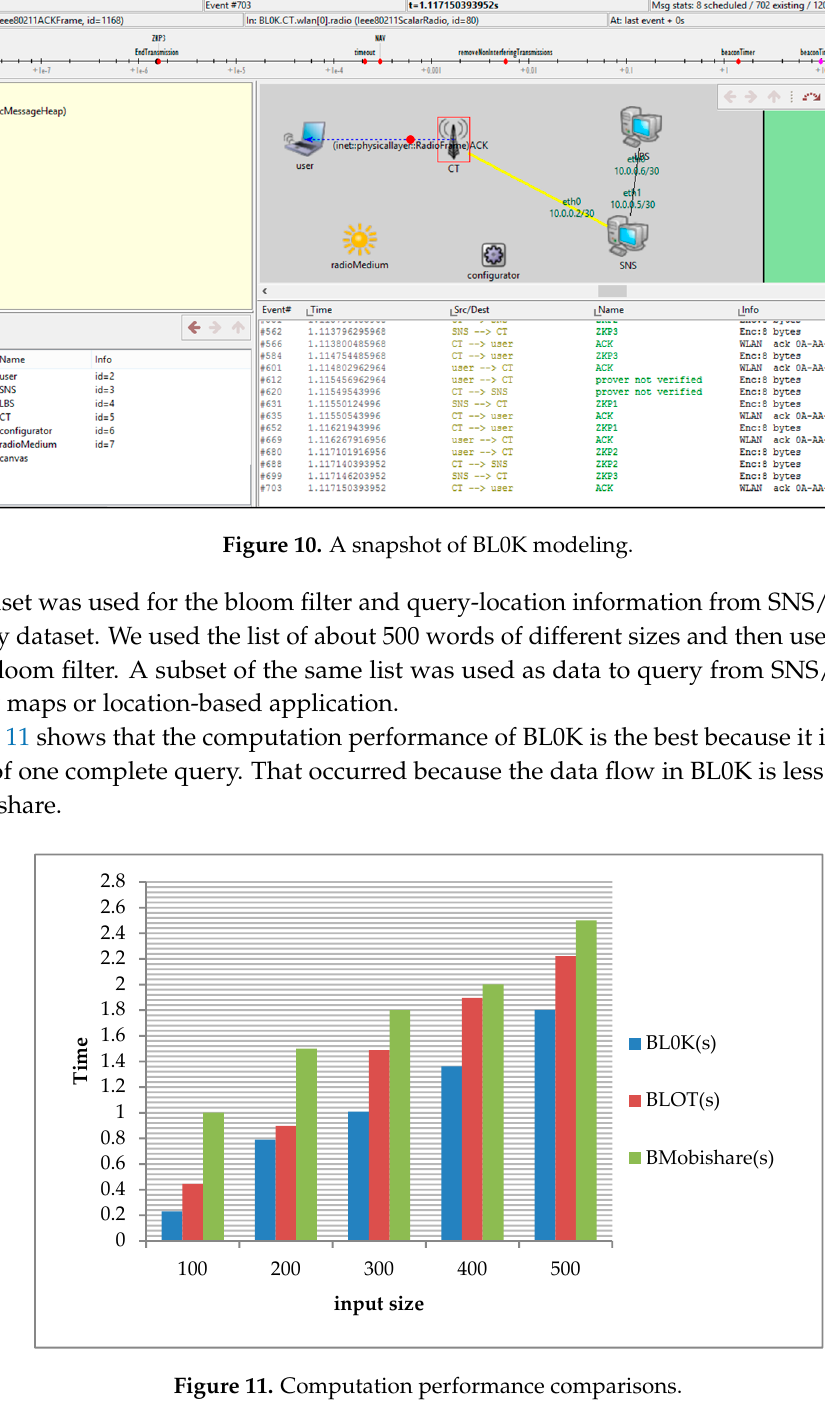
Figure 11. Computation performance comparisons.